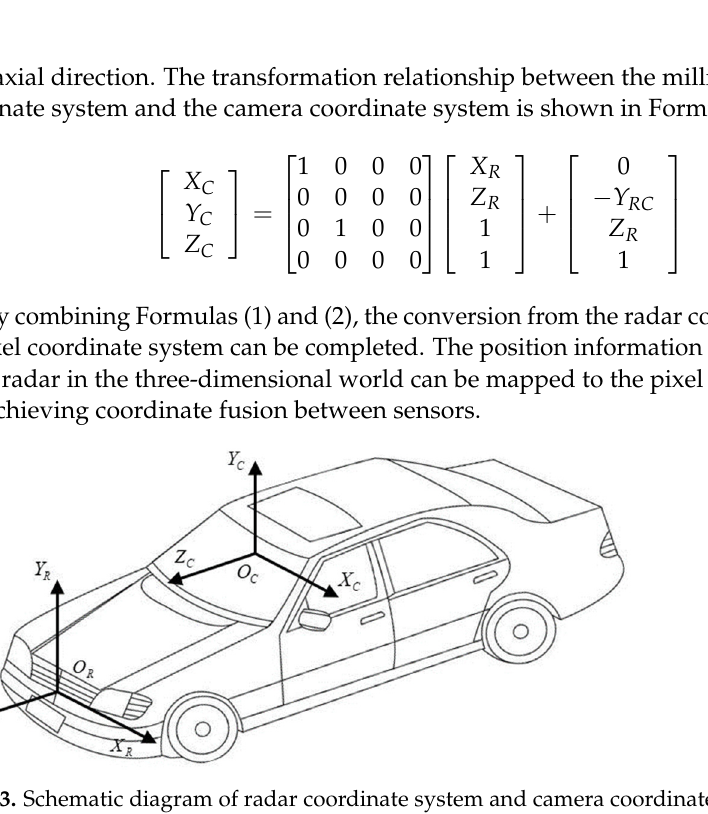
Figure 3. Schematic diagram of radar coordinate system and camera coordinate system.